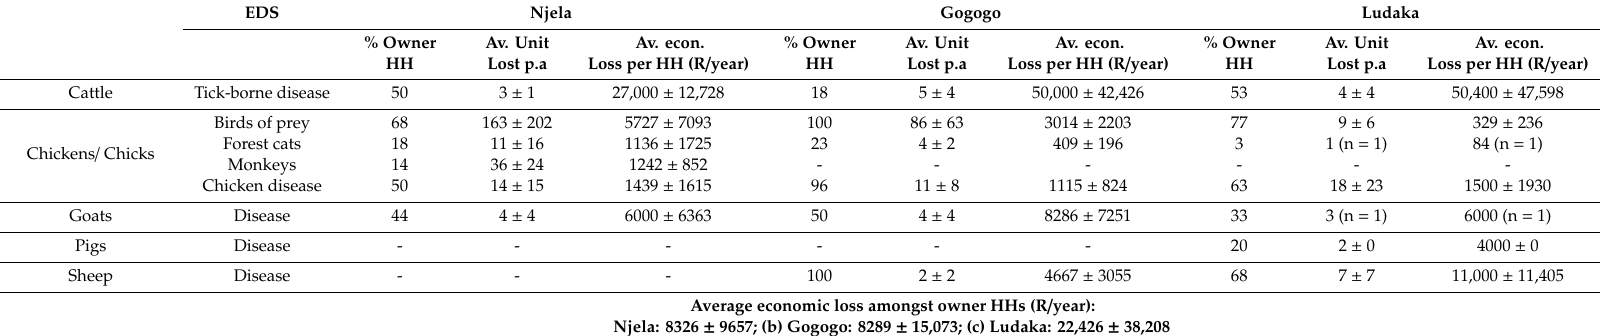
Table 6. Scope of the average economic loss per annum amongst owner households as a result of ecosystem disservices (EDS) 1 .